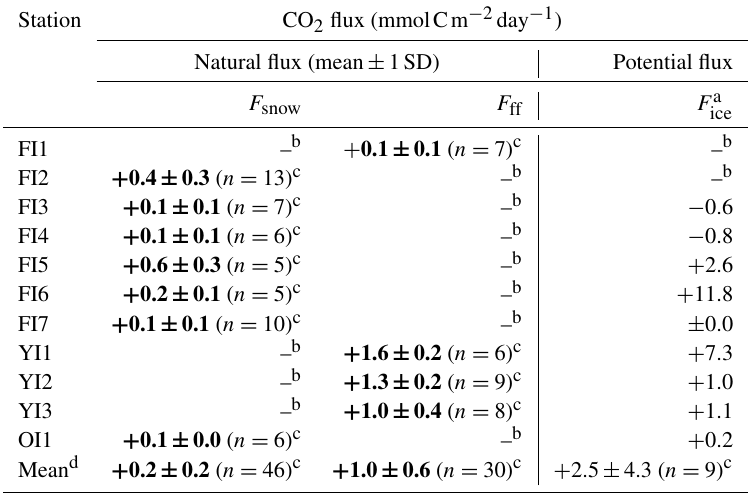
Table 3. CO 2 flux measured over the snow ( F snow ), frost flowers ( F ff ) and ice surface ( F ice ). Natural flux was emphasized as bold.